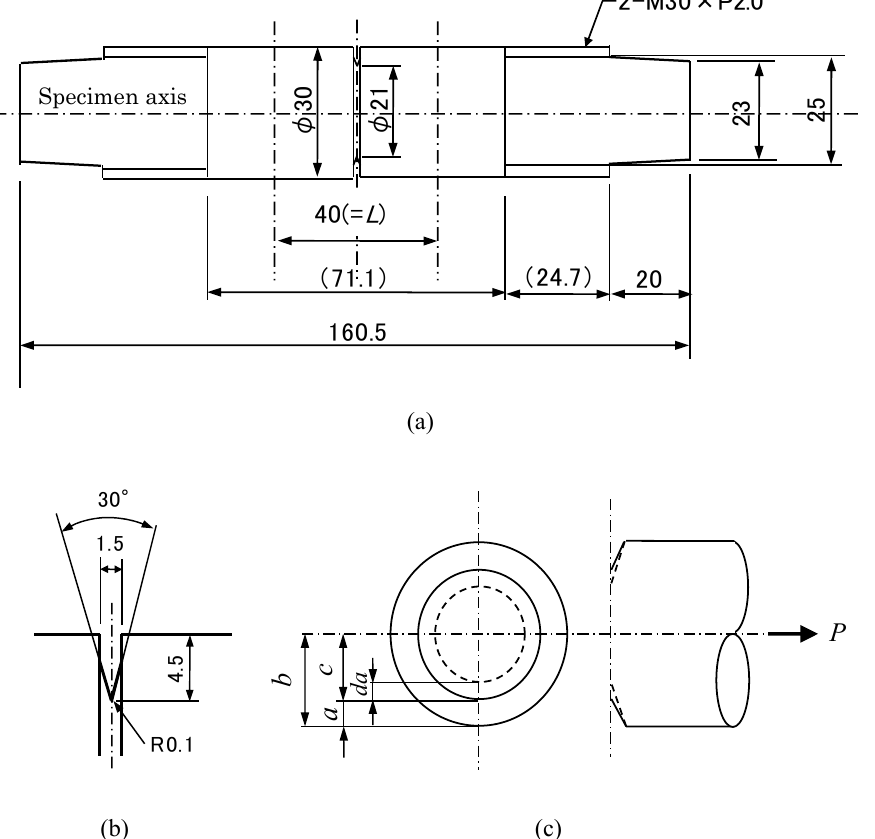
Figure 1. ( a ) Whole configuration of the round bar specimen, ( b ) detail of the notch, and ( c ) parameters of the cracked section (all dimensions in mm).